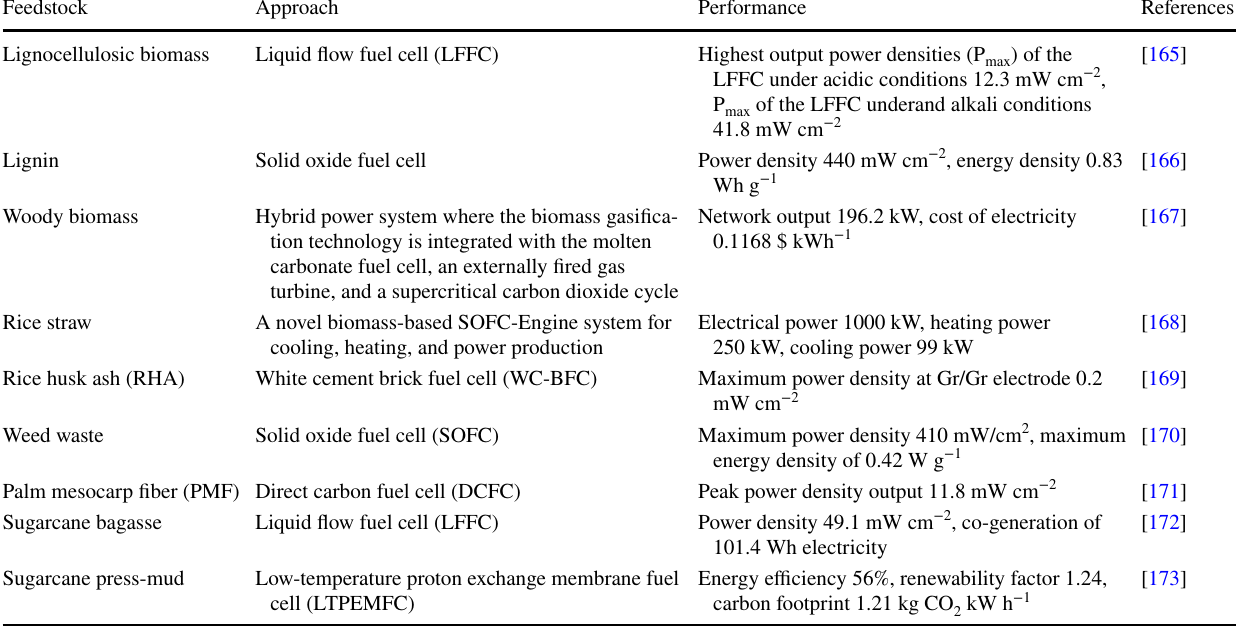
Table 4 Fuel cell system meet with HALUB Feedstock Approach